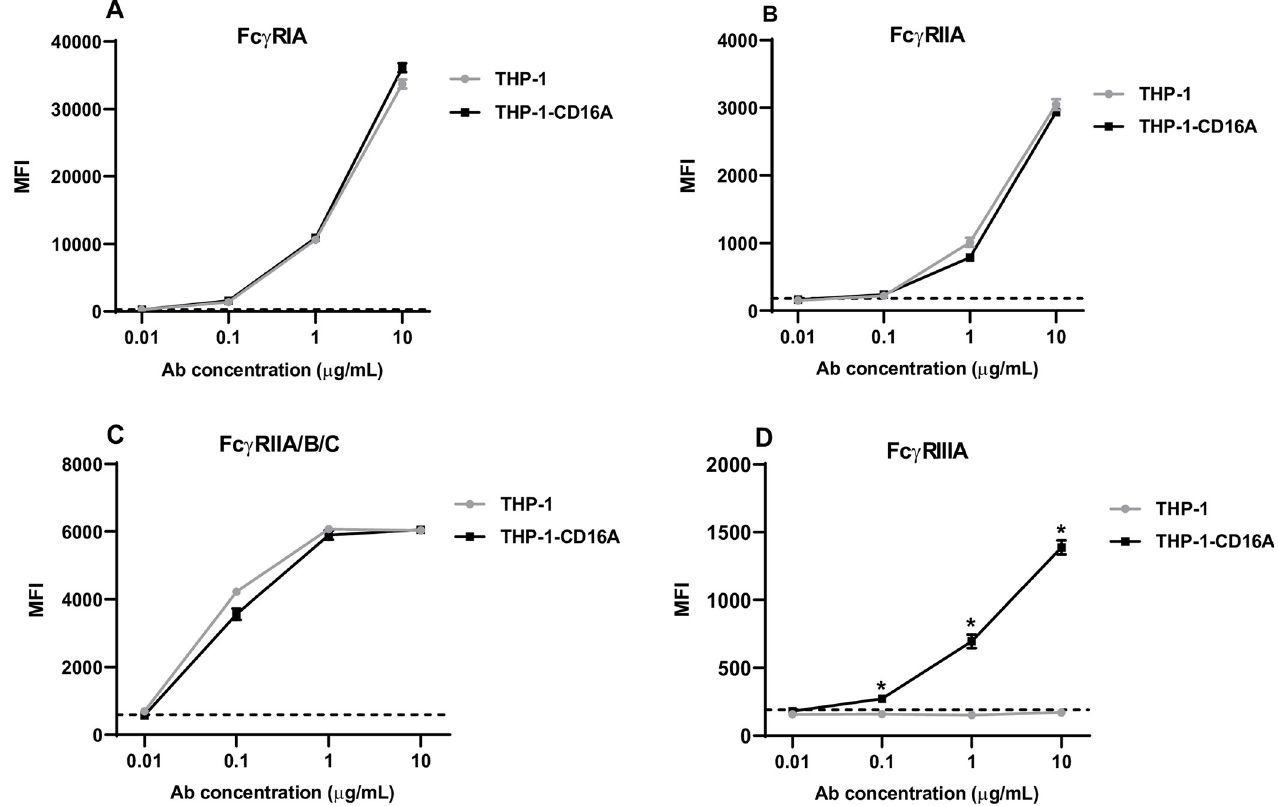
Fig 2. Expression of human Fc γ Rs on THP-1 and THP-1-CD16A cells. Five hundred thousand cells were stained with direct-labelled monoclonal antibodies against (A) Fc γ RI (clone 10.1 conjugated to PE/Cy7), (B) Fc γ RIIA (clone IV.3 conjugated to FITC), (C) Fc γ RIIA/B/C (clone AT10 conjugated to AF647), and (D) Fc γ RIIIA (clone 3G8 conjugated to BV421). Stained cells were washed and analyzed by flow cytometry using a BD LSRFortessa X-20. Data analysis was performed using FlowJo v10. Data are presented as the mean ± the standard deviation from four independent experiments. MFI: Mean fluorescent intensity (arbitrary units). Antibody concentration: Concentration of the fluorescent antibody for Fc γ R expression detection. The dashed line represents the MFI value for the corresponding isotype control at 10 μ g/mL. The statistical analysis was performed using the non-parametric Mann-Whitney T-test, comparing the MFI of both cell lines for each antibody concentration ( � : p =